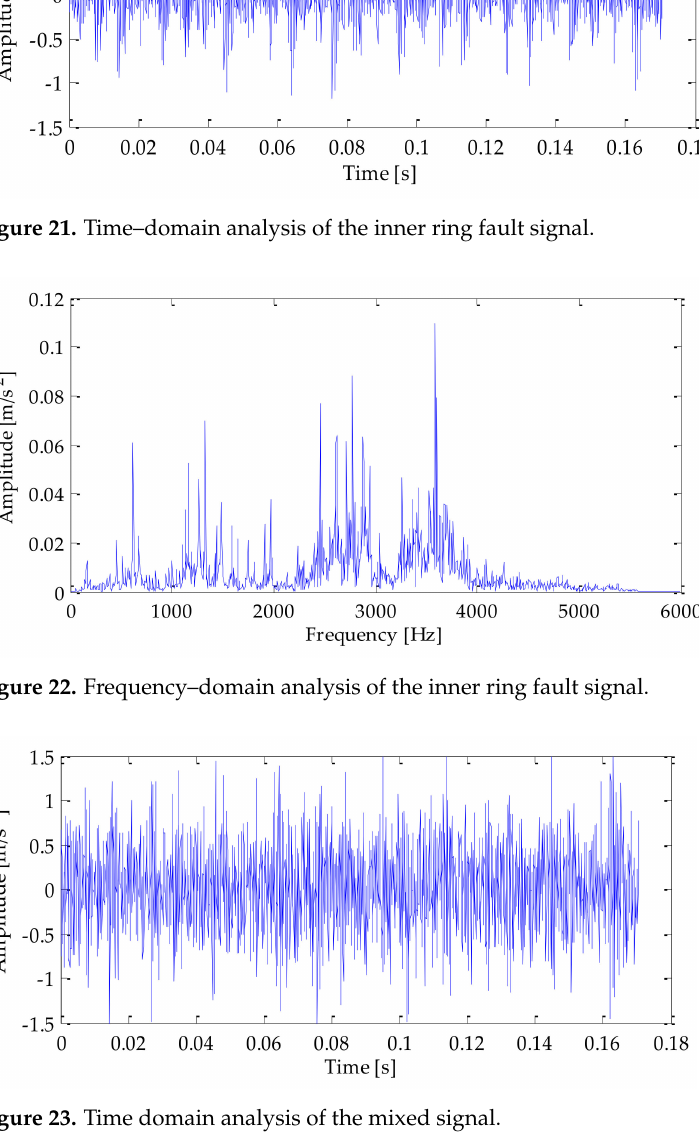
Figure 23. Time domain analysis of the mixed